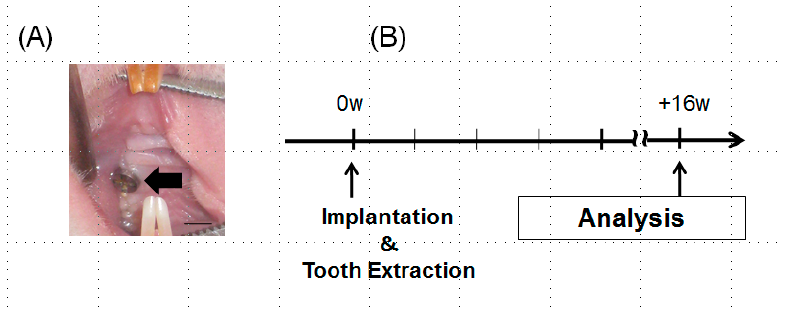
Table 1. Characteristics of culture disks and experimental implants.